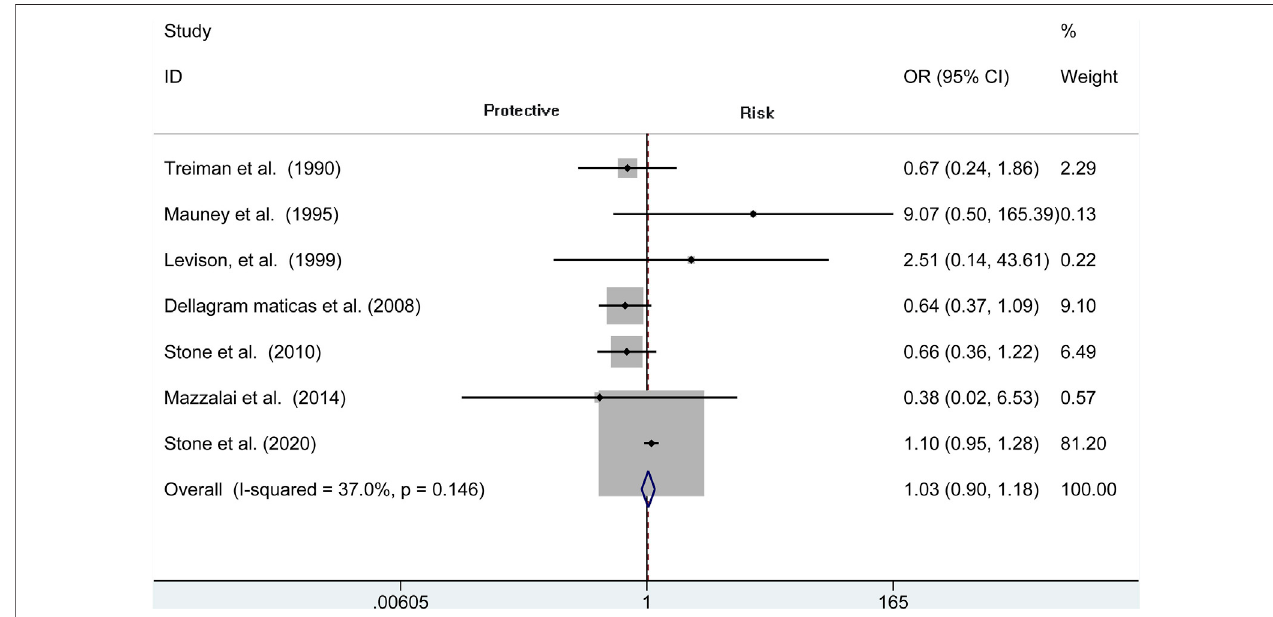
FIGURE 8 | Forest plot for meta-analysis of the incidence of stroke in the subgroup of CEA.